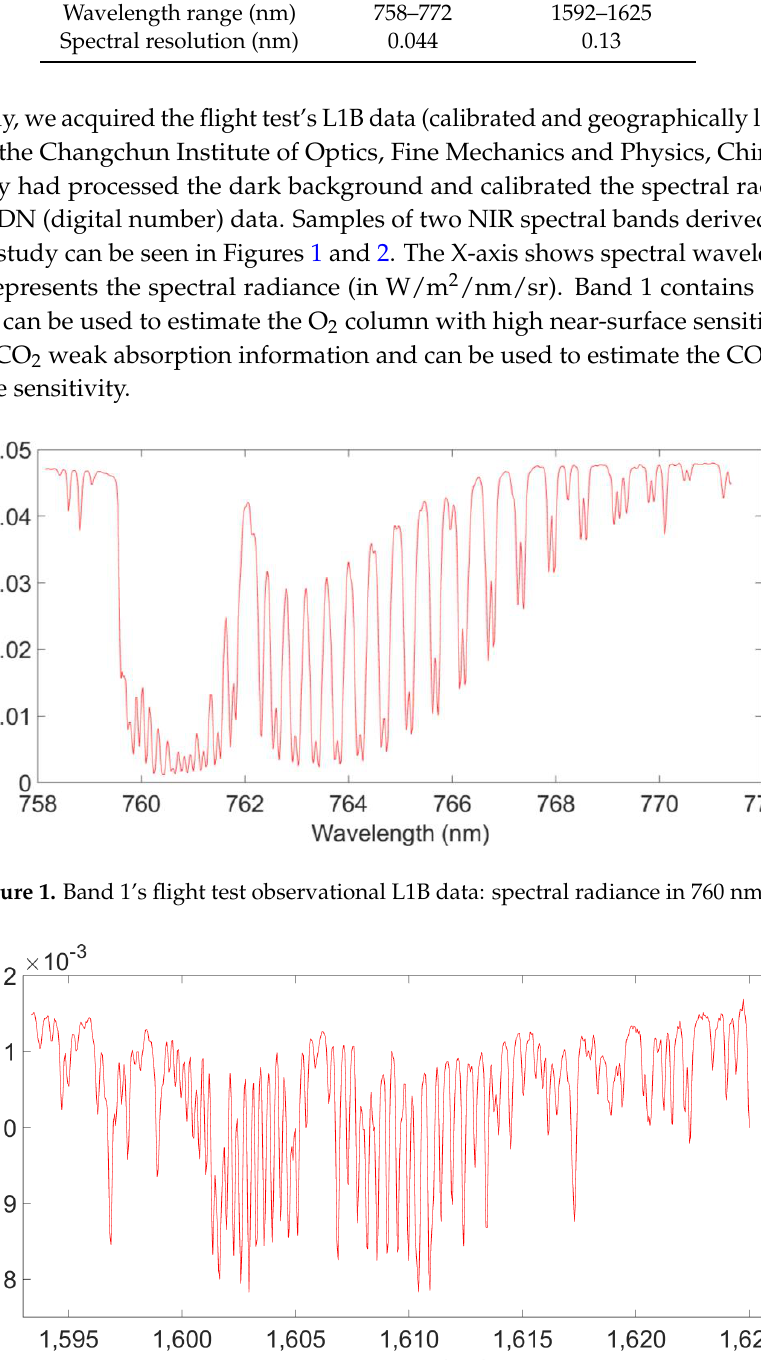
Table 2. NIR spectral bands used for the flight retrieval.